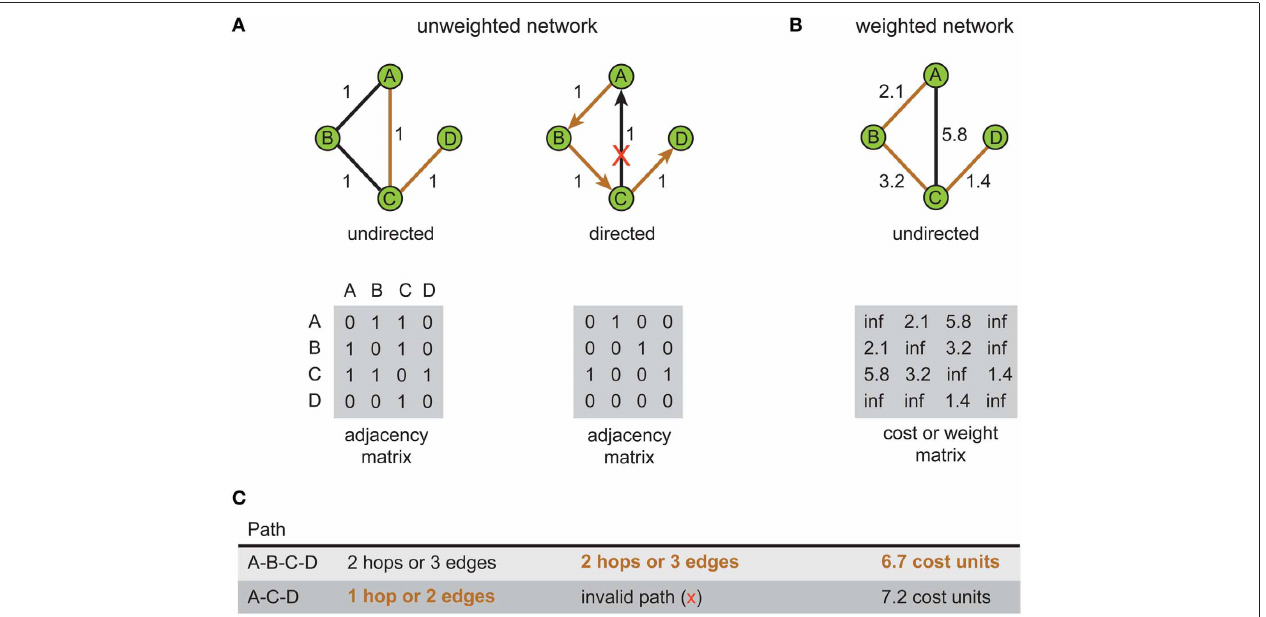
FIGURE 1 | Shortest path for the same problem can be different depending on the type of network representation used. An example network consists of four labeled vertices A, B, C, and D. The aim is to find shortest path between vertex A to vertex D. (A) Unweighted network representation. The topology of undirected (left) and directed versions (right) is shown graphically (top) with their corresponding adjacency (connectivity) matrices below (bottom). Brown lines show shortest paths. Red cross indicates a counter-directional edge, which